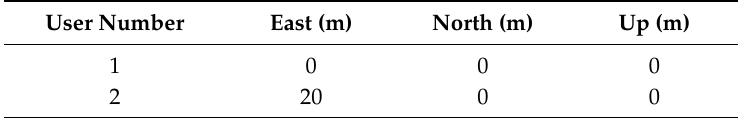
Table 1. The users’ east-north-up (ENU) coordinates of the outdoor scenario.